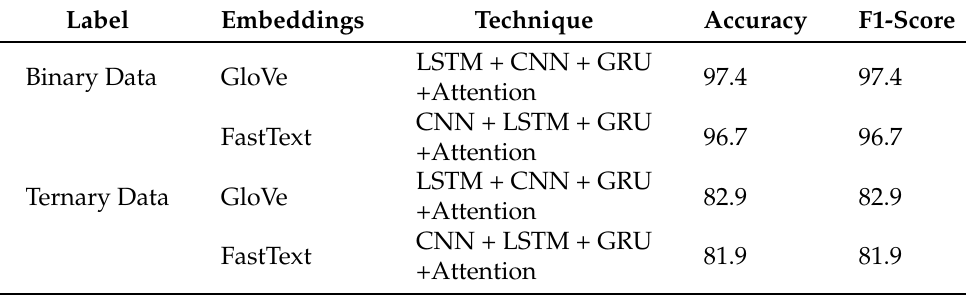
Table 15. Proposed method results on binary and ternary labeled data.